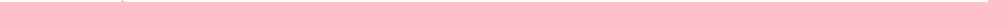
figure on next Fig. 2 Sequence polymorphism between cold tolerant and sensitive cultivars for OsRab11C1 . A LD map for the 19.1 kb region containing OsRab11C1 (indicated by the red arrow). Triangle plot for pairwise values (r 2 ) were plotted against physical genomic distantance between markers in the 19.1 kb region. The pairwise LD values of polymorphic SNPs are plotted on both the x‑and y‑axes. Each cell represents a comparison of two pairs of marker sites and the cells are color‑coded with respect to the presence of significant LD. A colored barcode for the significance threshold levels in both diagonals is shown. B Sequence analysis of the candidate gene OsRab11C1 in rice cultivars with extremely low and high survival rates. Tilted numbers at the top represent the position related to the initiation codon of the 5’‑UTR, ‘ ’ indicates the upstream region of the 5’‑UTR, and blank − rectangles indicate gene exon regions. The table shows sequence variation between the two groups of cultivars. A, T, G and C are the nucleotide bases, and ‘–’ indicates